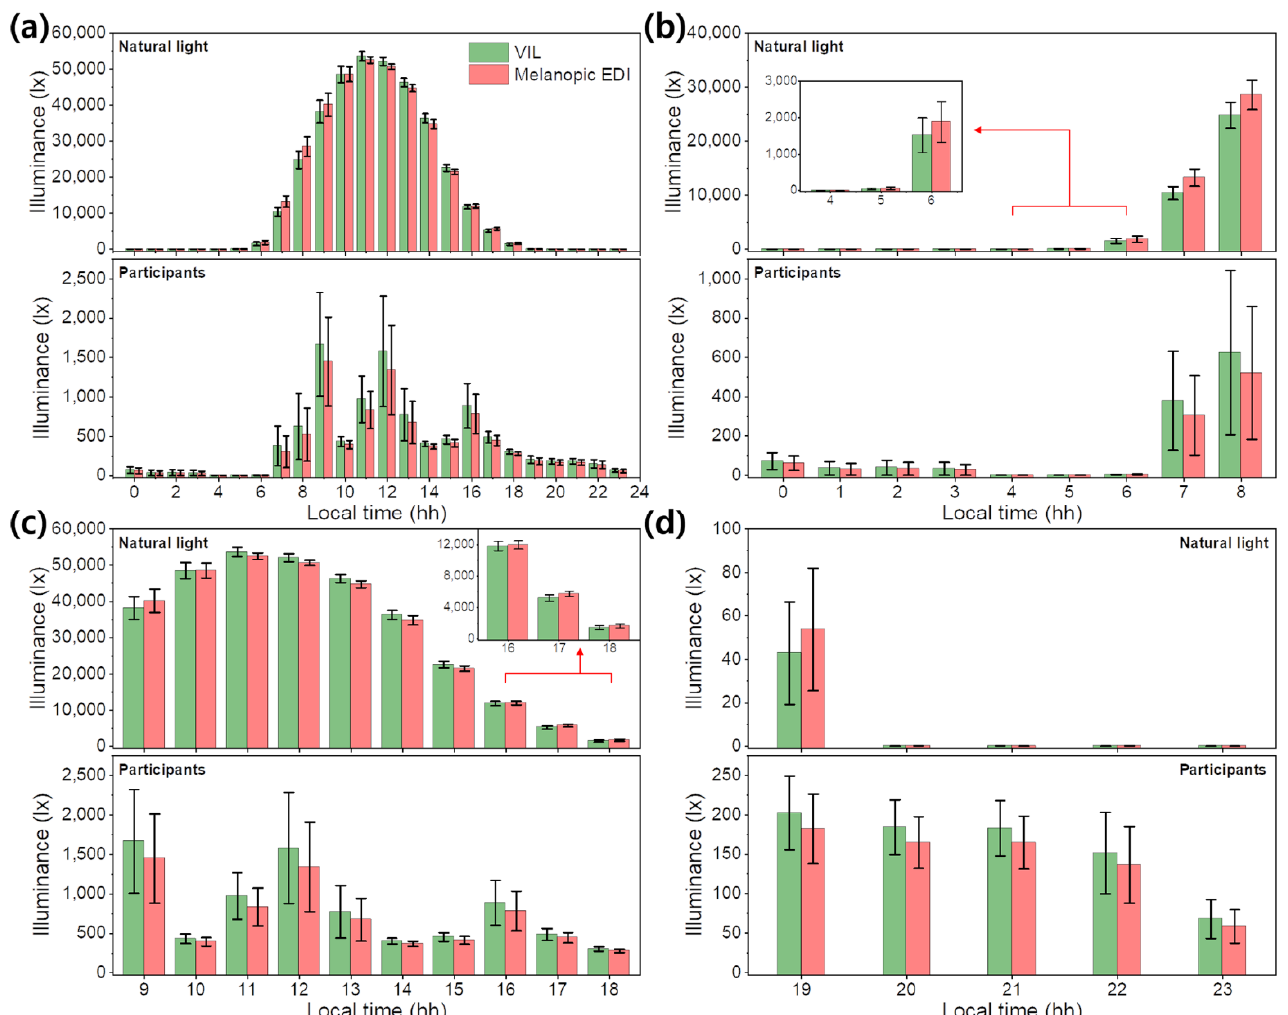
Figure 5. Illuminances of the natural light and light exposure of participants (N = 11), measured by the circadian light meter. ( a ) All 24 h, ( b ) dawn and morning (00:00–08:00), ( c ) daytime (09:00–18:00), and ( d ) nighttime (19:00–23:00) illuminances expressed at hourly intervals. The natural light illuminances were obtained from the roof of a five-story building. The participants acted according to their usual habits without any behavioral restrictions. The illuminance data of the natural light and light exposure of participants were simultaneously obtained from 20 March to 30 April 2020. All data represent mean ± SEM; all legends are identical, as shown in ( a ).